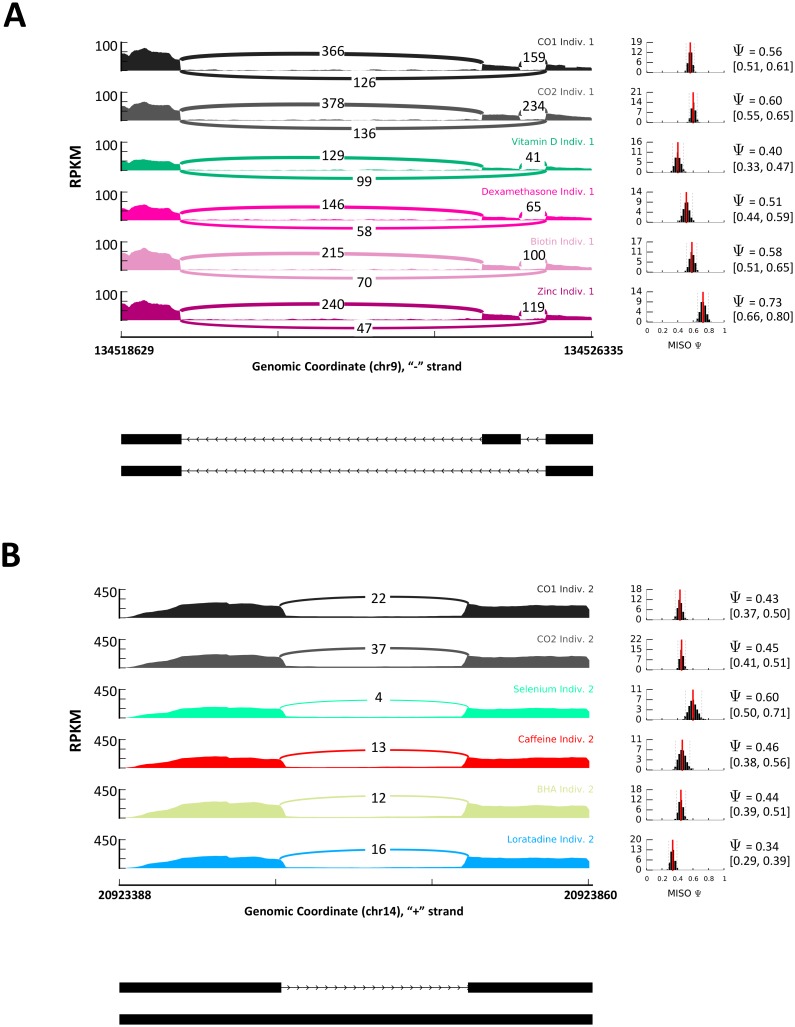
Example of RNA processing across treatments in one individual.The plots on the right show the Ψ value for each sample with confidence intervals. The plots to the left show the read coverage in each exon with a model of this region below each read coverage plot. A) Sashimi plot showing SE shift in RAPGEF2 in PBMCs following exposure to 4 treatments (vitamin D, dexamethasone, biotin and zinc) and both controls. B) Sashimi plot showing RI shift in APEX1 in melanocytes following exposure to 4 treatments (selenium, caffeine, BHA and loratadine) and both controls.